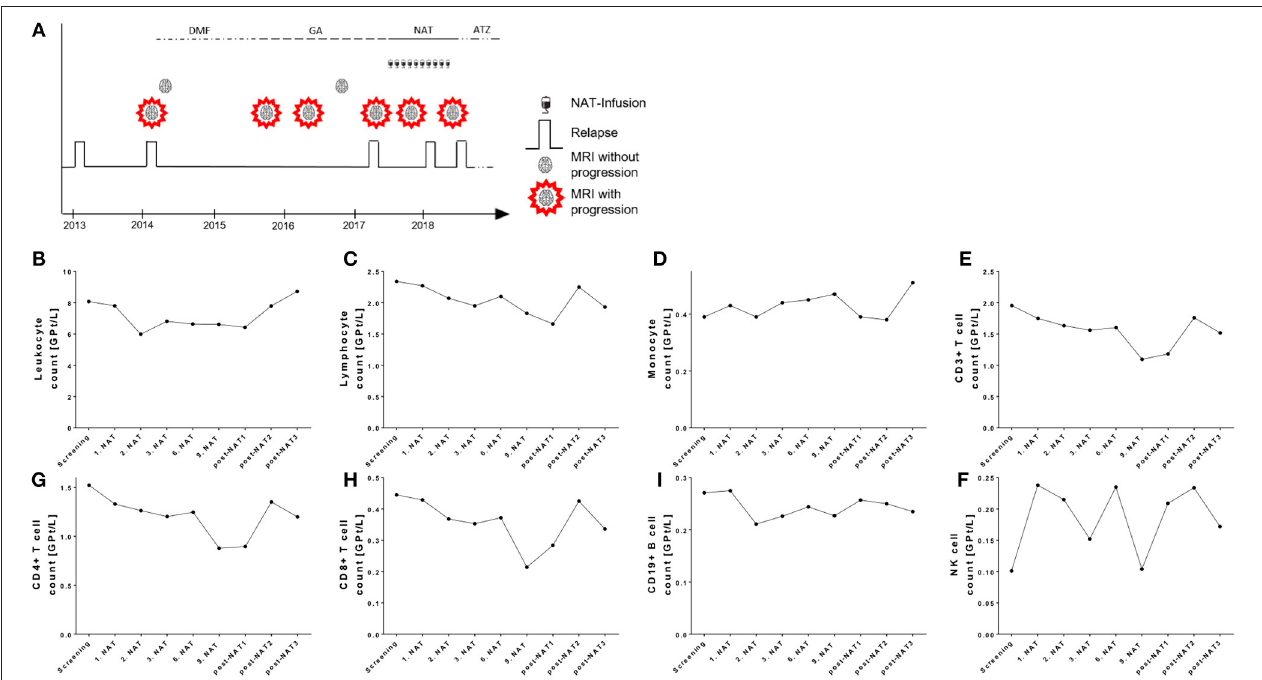
FIGURE 6 | Case presentation and course of peripheral immune cell subset in a NAT treated patient with positive nAbs. (A) Clinical data including relapse activity, MRI progression, and treatment conditions are presented. DMF, dimethylfumarate; GA, glatiramer acetate; NAT, natalizumab; ATZ, alemtuzumab. (B–I) Absolute cell count of leukocytes (B) , lymphocytes (C) , monocytes (D) , CD3 + T cells (E) , CD4 + T cells (F) , CD8 + T cells (G) , CD19 + B cells (H), and NK cells (I) are depicted. Data are shown for screening, NAT treatment period (1. NAT, 1st NAT infusion etc), and period after NAT cessation (post-NAT1, post-NAT2, post-NAT3; 1, 2, or 3 months after NAT stop).